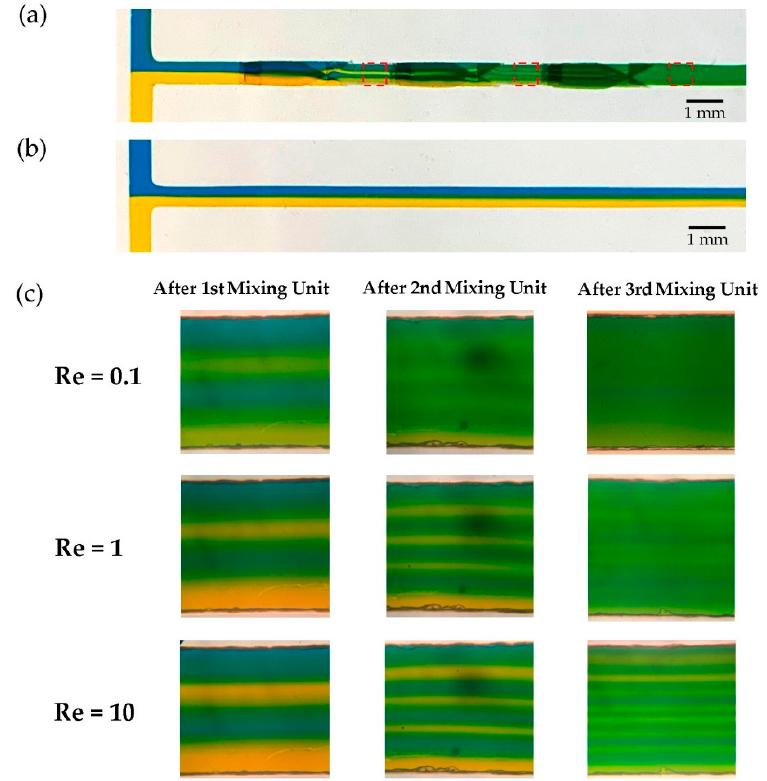
Figure 5. Experimental results of the micromixer performance. ( a ) Macroscopic image of the proposed device, mixing blue and yellow dyes at Re = 1. The fluid layers mimicked the pattern predicted by the numerical simulations, illustrated in Figure 4. Fluid layers were generated as expected. A slight misalignment was caused during the fabrication step. Based on our experience, the device had robust output against it and performed well. ( b ) A straight channel was fabricated with the same channel width, height and length. It was tested with the same test condition as ( a ). Two phases were lightly mixed at the outlet in the absence of 3D mixing elements. ( c ) Microscopic images of the main channel after three mixing units for three different Reynolds numbers (Re = 0 1, 1 and 10) show that an incomplete mixing was captured at the outlet for high flow rate (Re = 10). In contrast, more efficient mixing was achieved in the case of lower fluid flow rates. Images show the region at the distance of 0.5 mm downstream of mixing units, where MI is calculated.